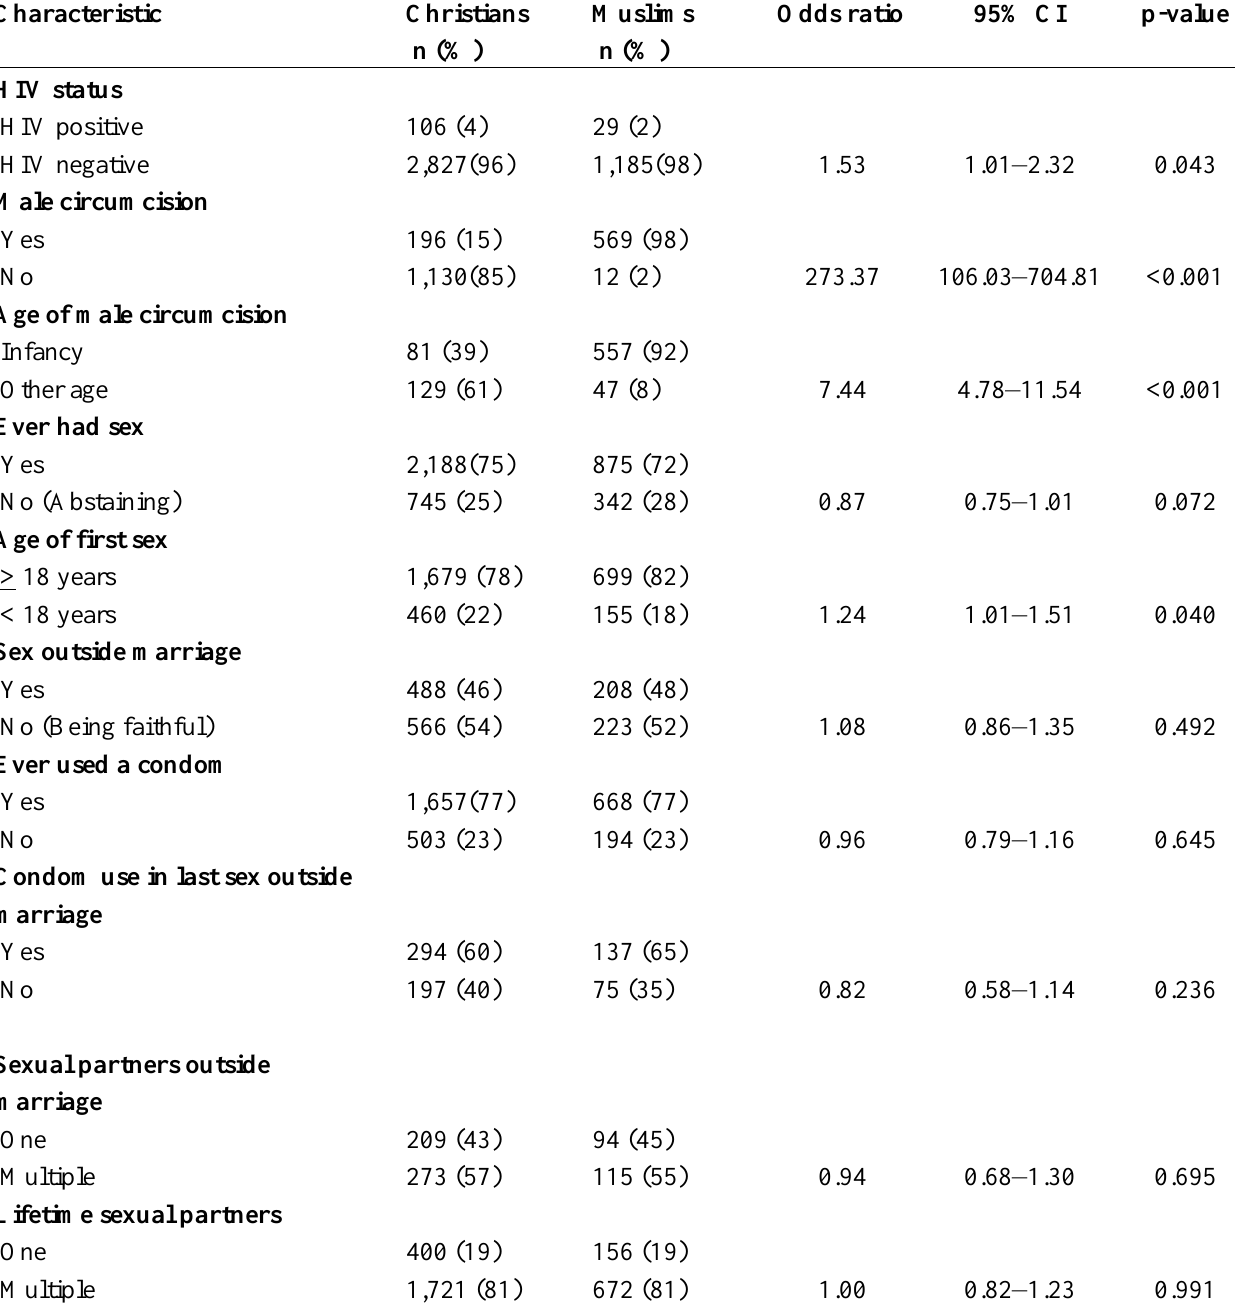
Table 2. Comparison of HIV status and HIV-risk behaviors and practices among Muslims and